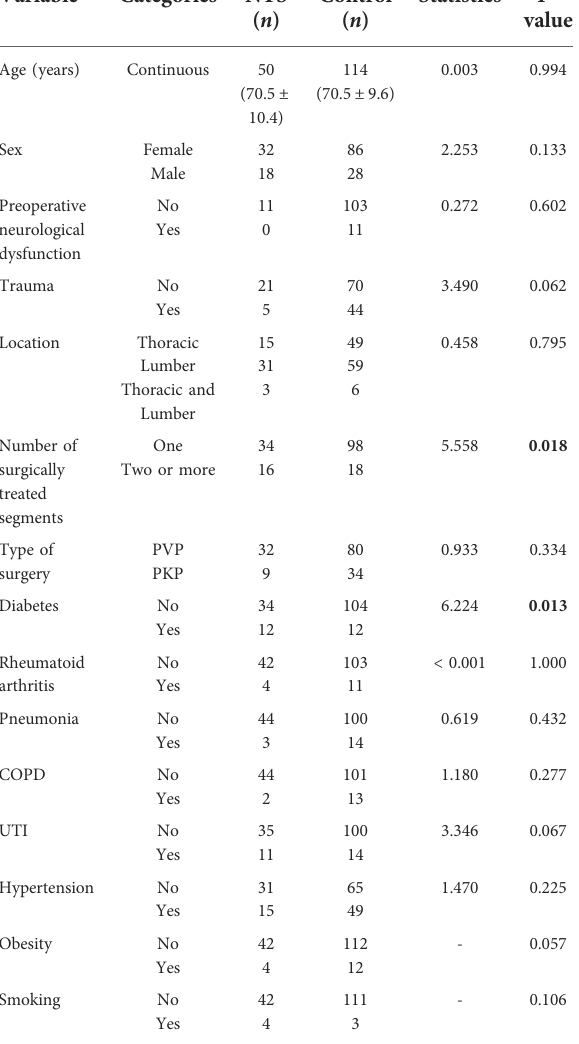
TABLE 5 Comparison of clinical features between NTS and Control group.